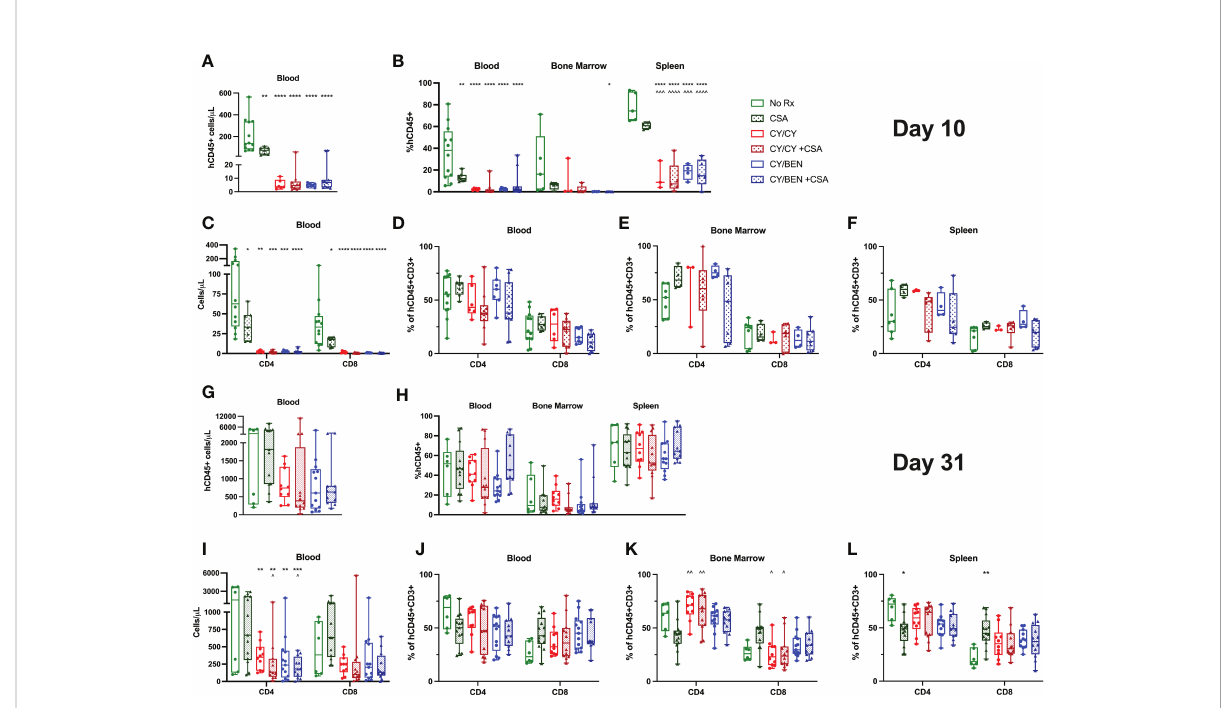
FIGURE 4 Post-PBMC infusion chemotherapy with or without CSA signi fi cantly reduces total human CD45+ cells and T cells at day 10 with a sustained reduction in circulating absolute CD4 T cell counts at day 31. PBMC-infused mice were given indicated treatments and blood, bone marrow, and spleens were collected for analysis on (A-F) day 10 or (G-L) day 31. (A, C, G, I) Absolute numbers were calculated per microliter of blood using counting beads for (A, G) total CD45+ or (C, I) CD4+ or CD8+ T cells. (B, H) Percentage of human CD45+ cells out of total cell numbers in blood, bone marrow and spleen. (D-F, J-L) percentages of CD4 and CD8 T cells in (D, J) blood, (E, K) bone marrow and (F, L) spleen. (A-L) Signi fi cant differences were determined via a one-way ANOVA followed by Tukey ’ s post-hoc comparisons. P values are indicated by the number of symbols between groups noted on graphs, *<0.05, **<0.01, ***<0.001, ****<0.0001. Asterisks (*) indicate signi fi cant differences from no Rx, arrows (^) indicate differences from CSA